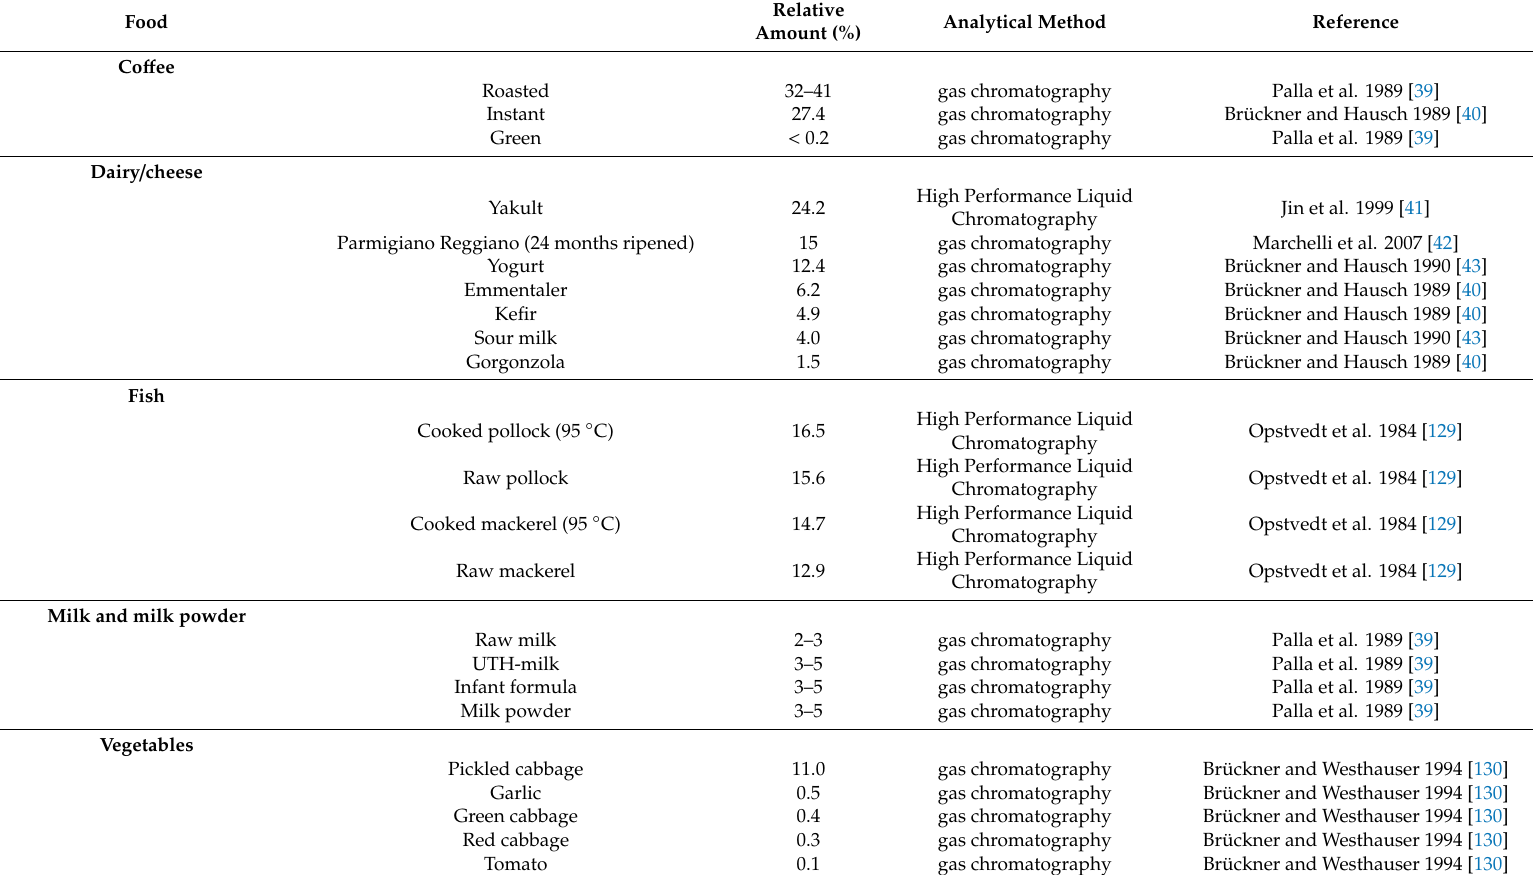
Table 1. Distribution of d -glutamate in foods. The reported percentage of d -glutamate is relative to the total amino acid